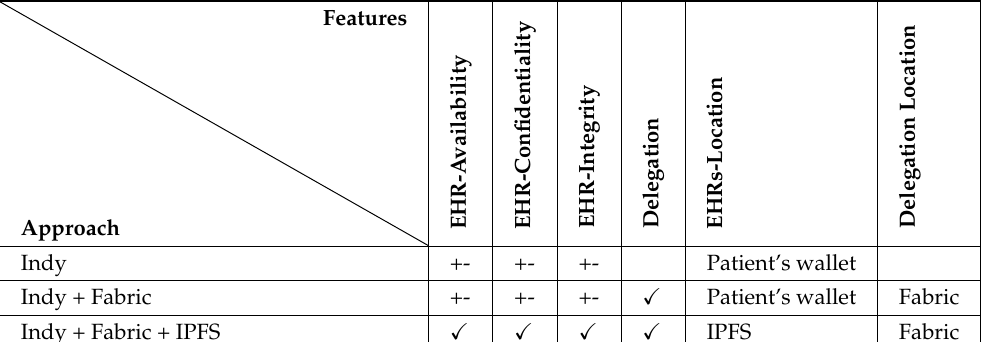
Table 11. Differences between the proposed architectures. Features